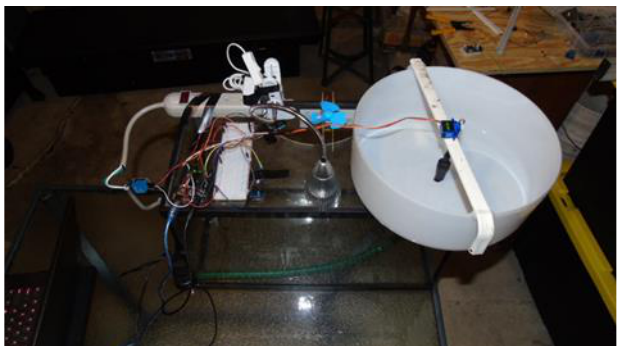
Figure 2. Smart greenhouse overview